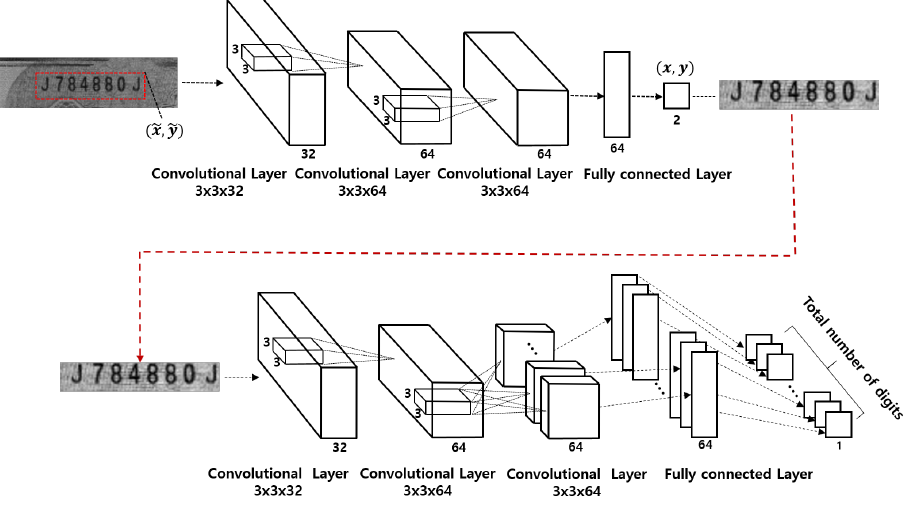
Figure 5. The sequential ROI detection and classification